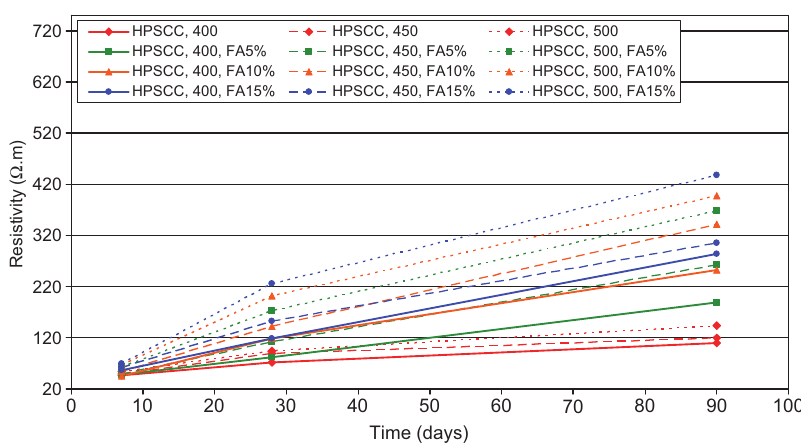
Figure 11 Resistivity vs. time for mixtures with different cement contents and fly ash percentages.